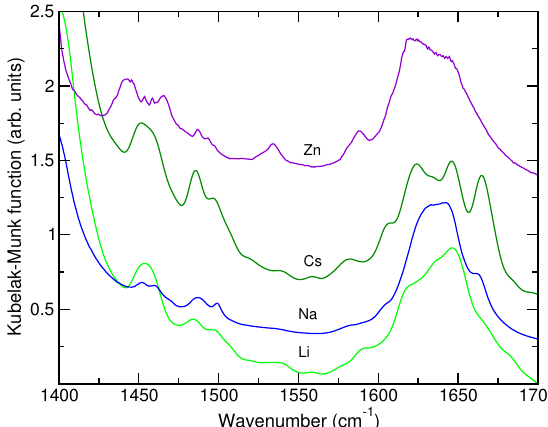
Figure 4. Experimental DRIFT spectra of the SA@silicalite and SA@M-ZSM-5 samples with M = Li + , Na + , Cs + , Zn 2+